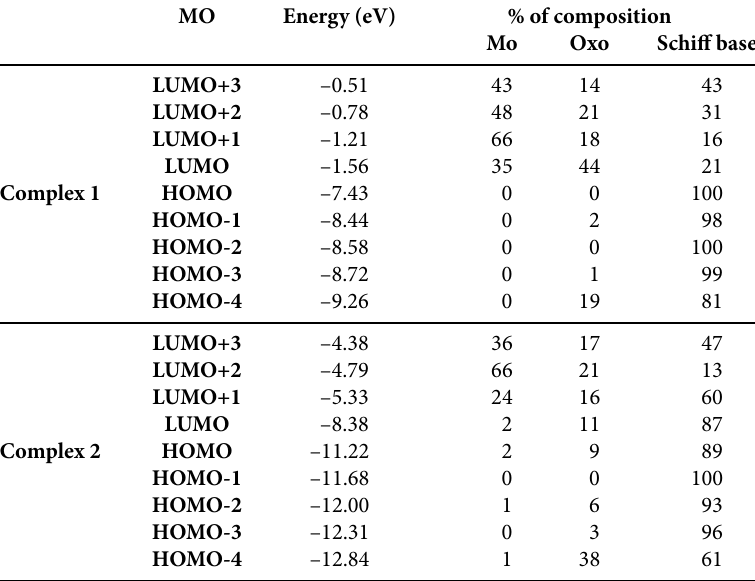
Table 2. Energy and composition of some selected MOs of Mo